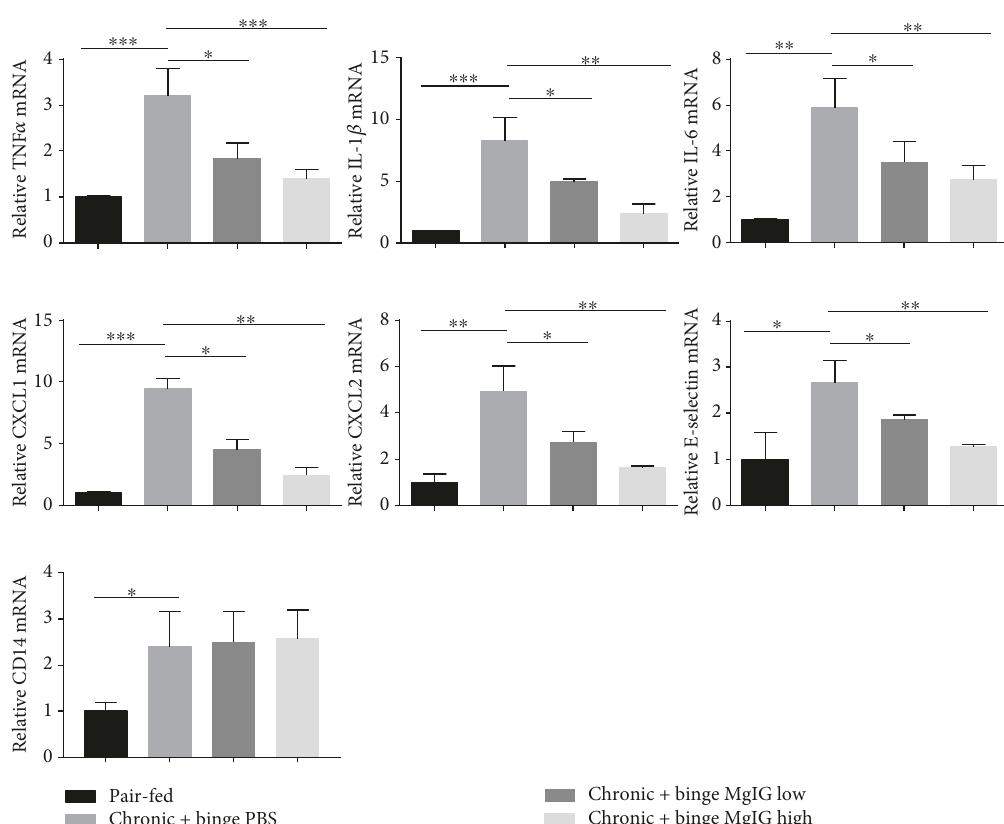
Figure 3: MgIG prevents chronic plus binge ethanol feeding-induced proin fl ammatory mediator expression. Gene expression of proin fl ammatory cytokines (TNF α , IL-1 β , and IL-6), neutrophil migration-related chemokines (CXCL1 and CXCL2), neutrophil adhesion molecule (E-selection), and Kup ff er cell activation marker (CD14) in the liver. Values represent means ± SEM. ∗ p < 0 05 ; ∗∗ p < 0 01 ; ∗∗∗ p < 0 001